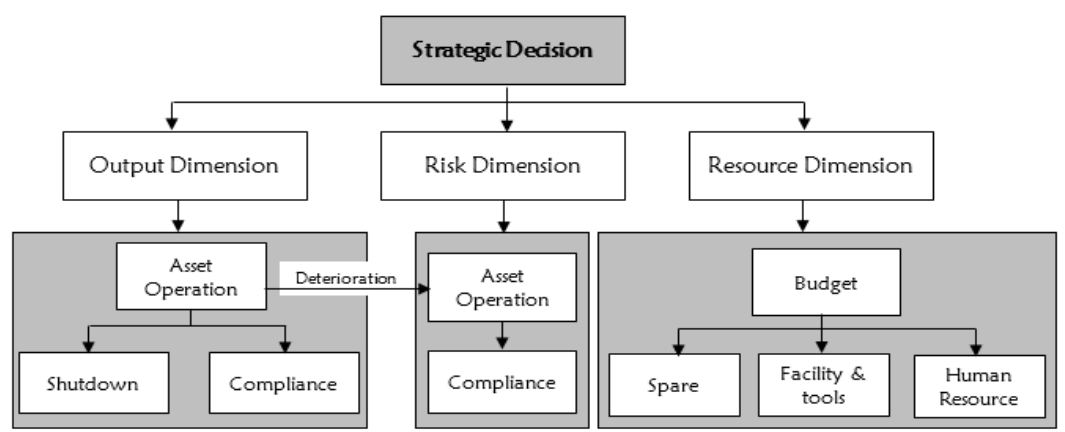
Figure 2: Strategic maintenance framework (Price, 2007)